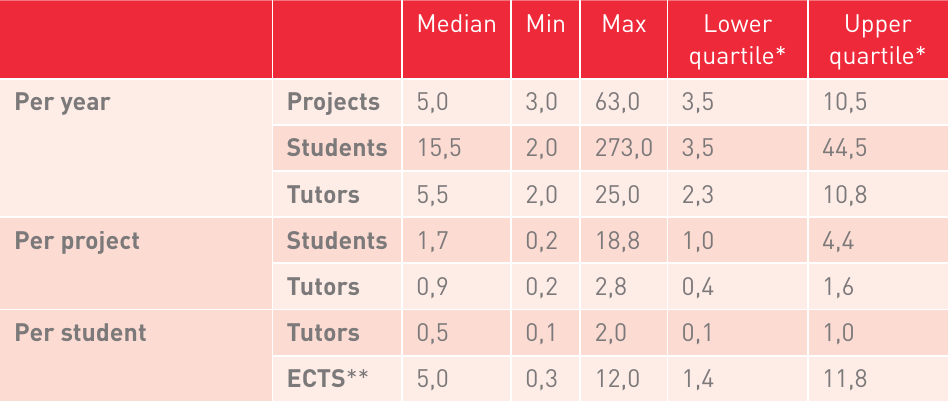
Table 1 Projects, students and tutors involved: Median values and variability of